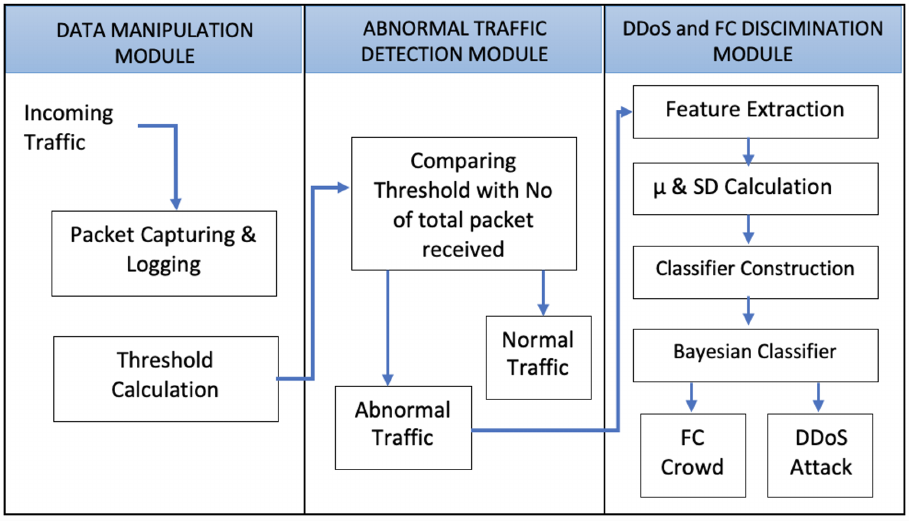
Figure 1. The proposed system